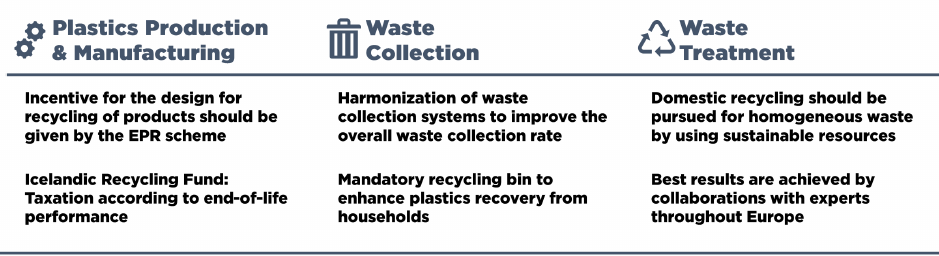
Figure 2. Summary of recommendations obtained from expert interviews to enhance plastics recycling in Iceland by improvements throughout the value